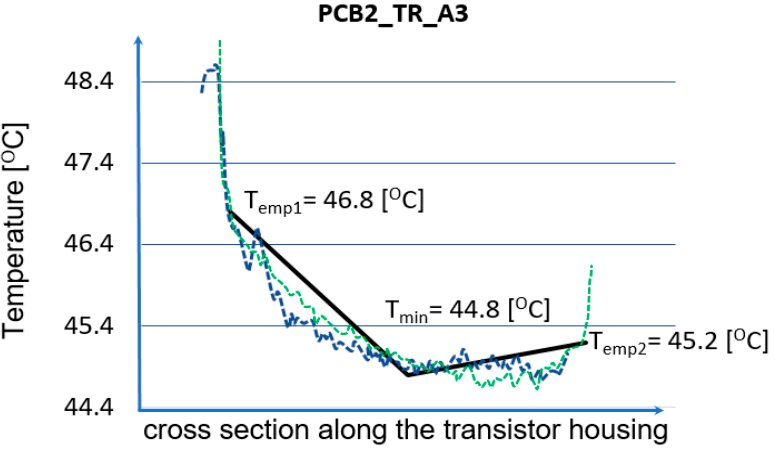
Figure 15. Method of determining the temperature values T emp1 , T emp2 , and T min from the thermogram of the temperature distribution on the transistor case.